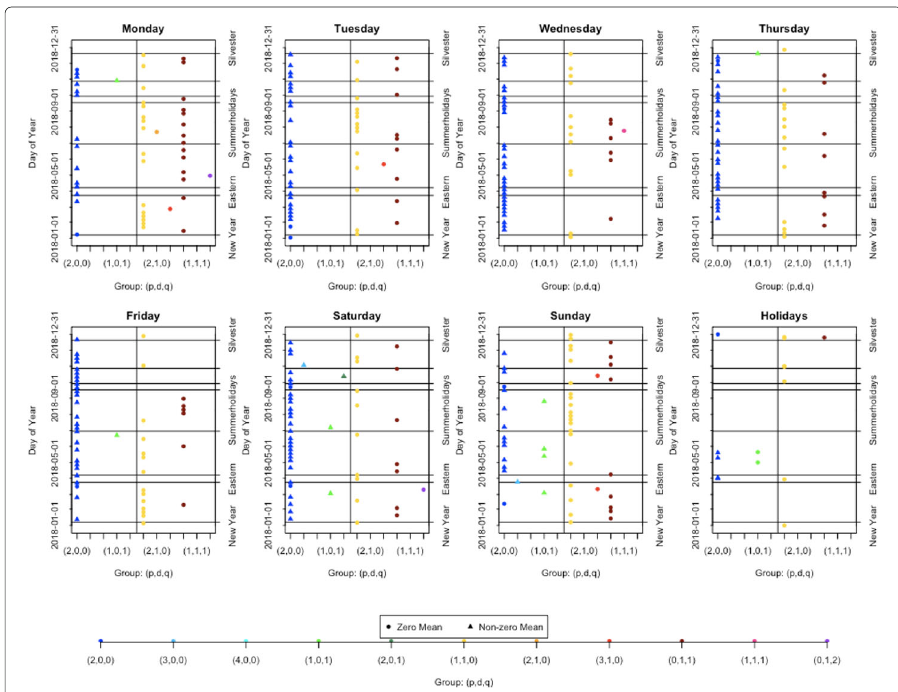
Fig. 7 Cluster of the Day-Ahead prices with mAIC as similarity function